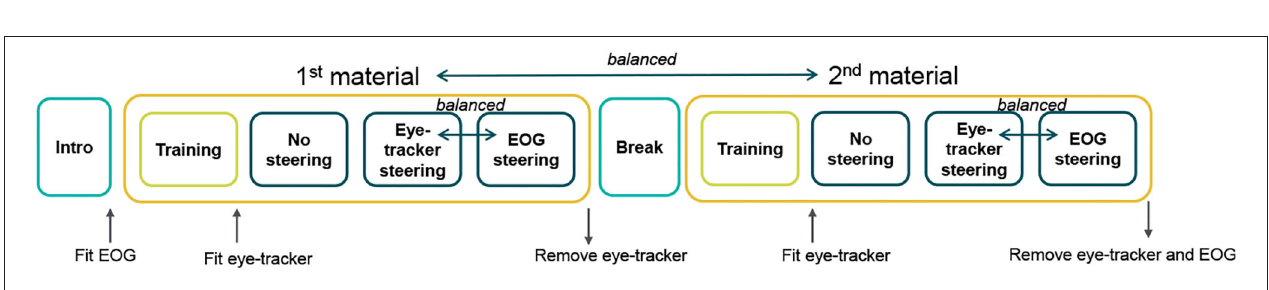
FIGURE 4 | Schematic overview of the procedure used for each test